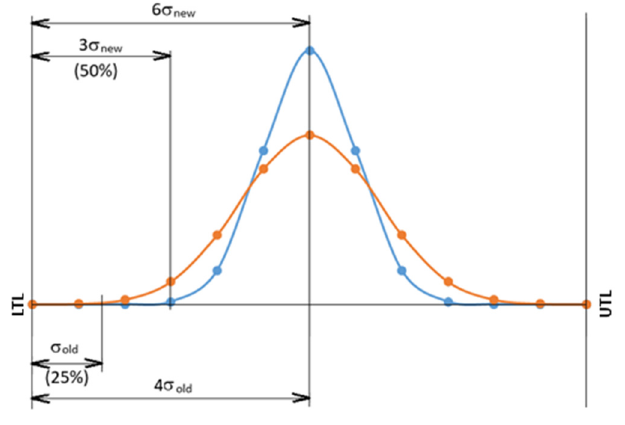
Figure 1. Improving the process precision: 6 σ precision versus 4 σ precision.